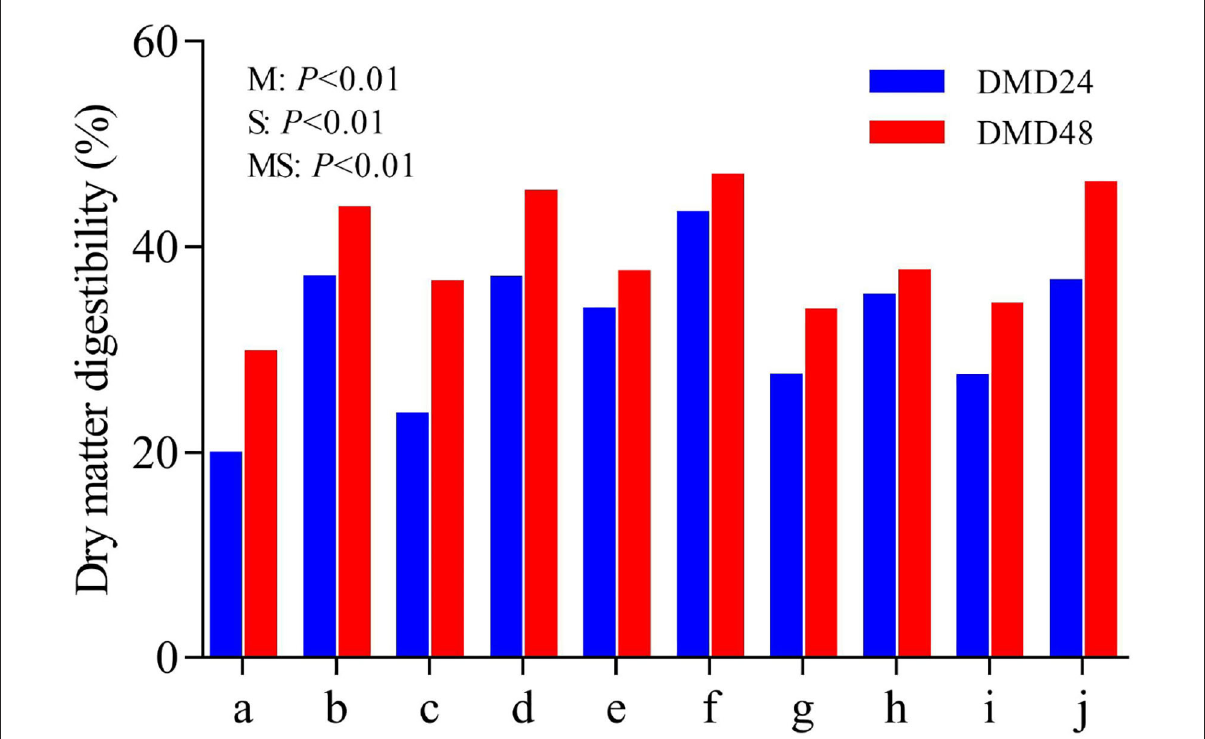
FIGURE5 In vitro dry matter digestibility (DMD) of feedstuff before and after steam explosion processing (a: raw corn cob; b: steam-exploded corn cob; c: raw rice straw; d: steam-exploded rice straw; e: raw peanut shell; f: steamed-exploded peanut shell; g: raw millet stalk; h: steamed-exploded millet stalk; i: raw sugarcane tip; j: steam-exploded sugarcane tip; M: the effect of raw material; S: the effect of processing; MS: the interaction of raw material by